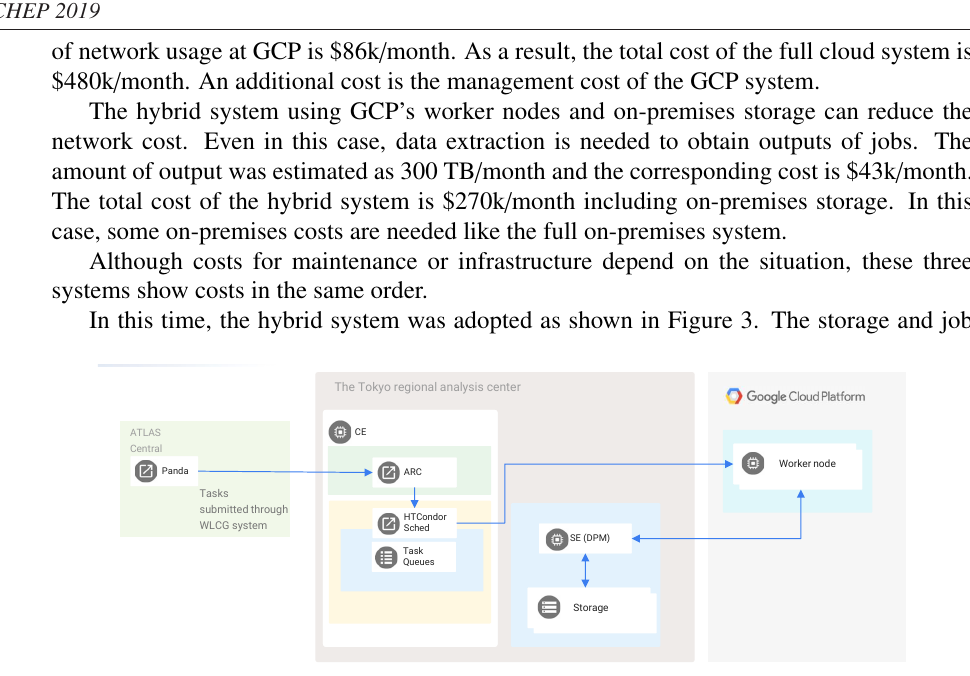
Figure 3. The schematic view of the hybrid system with